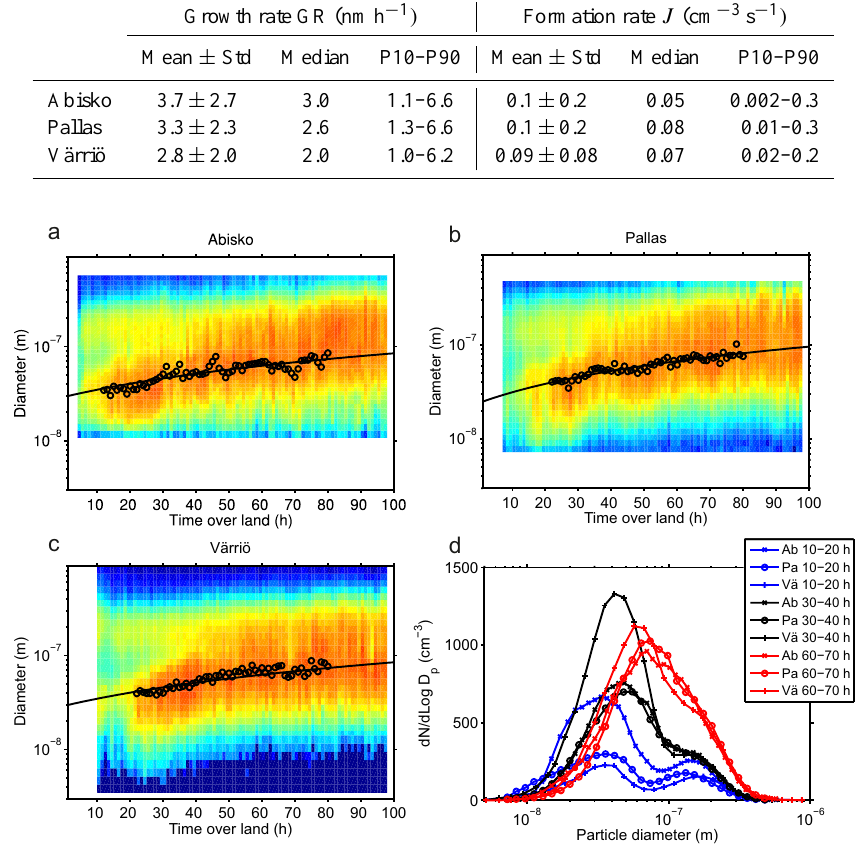
Fig. 4. (a–c) Median number size distributions as a function of time the corresponding air mass has spent over land during the last 96h. Only summer period (1.4–30.9) covered. (d) Mean number size distributions for certain time periods for all